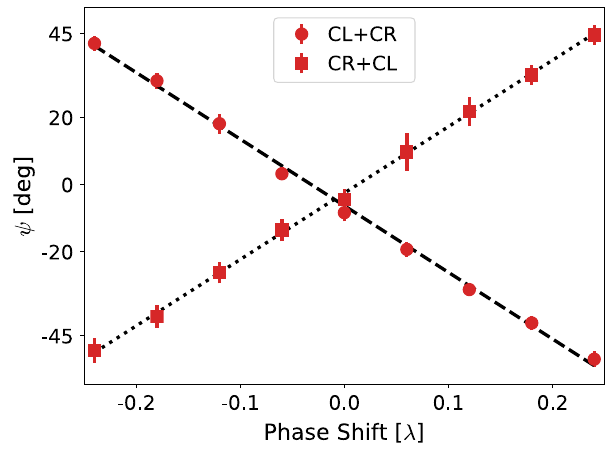
FIG. 16. Direction of the linear polarization vector as a function of the phase between the circularly polarized fields with opposite chirality. The distributed scheme was used. The dotted and dashed lines show the expected linear dependence. By swapping the chiralities of each undulator the same linear dependence can be observed, but with opposite sign. The data were obtained by the statistical analysis (average and standard deviation) of 40 consecutive shots at the same phase shift